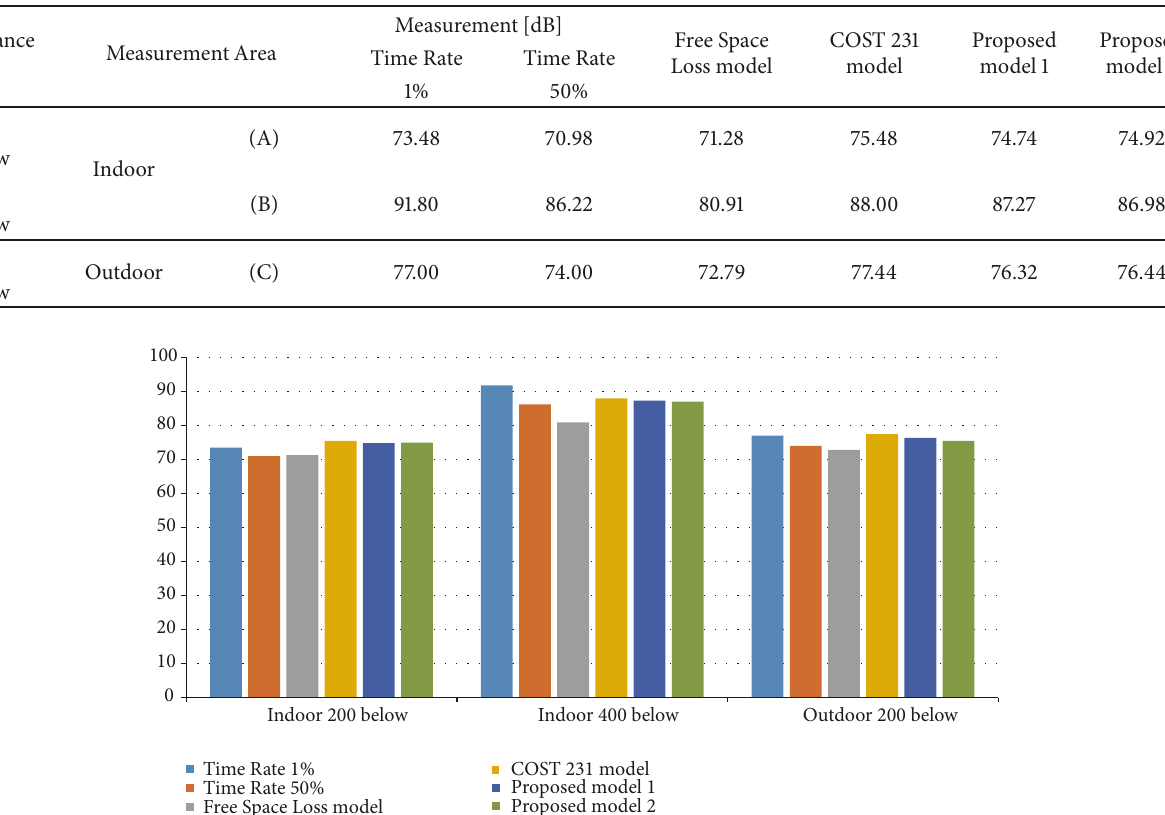
Table 5: Compare with the proposed model and the measurement results.